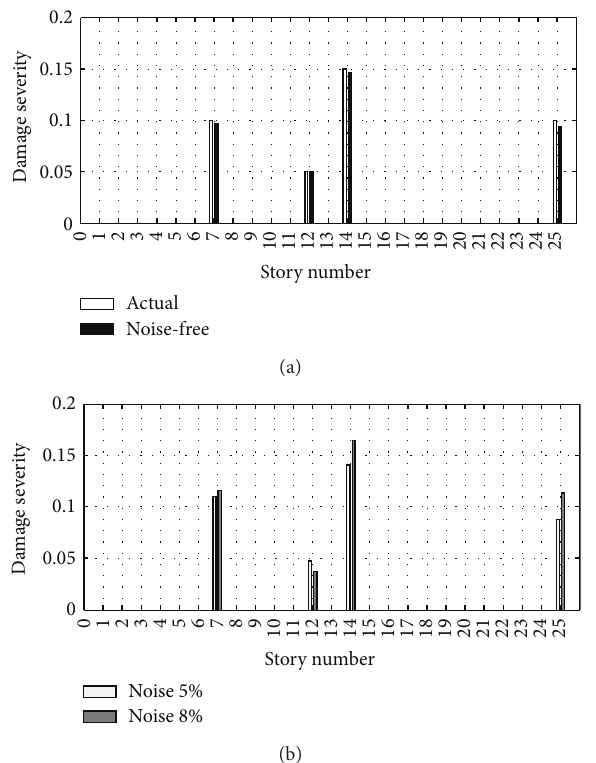
Figure 16: Damage detection results in the 25-story shear frame for scenario III.